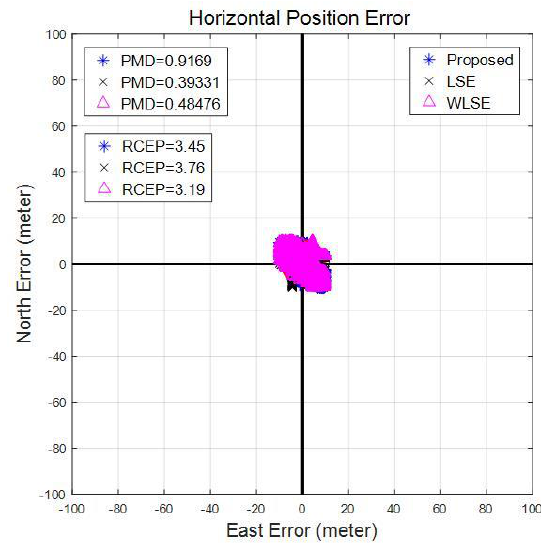
Figure 4. Horizontal radial error of open sky static scenario.